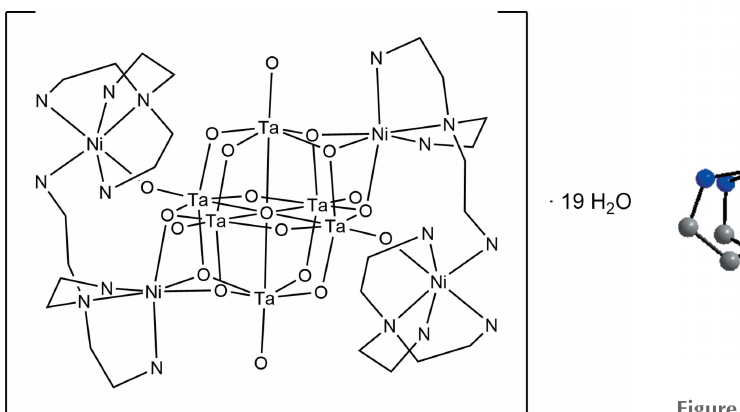
Figure 2 View of the cluster motif of the title compound. Hydrogen atoms were omitted for clarity.